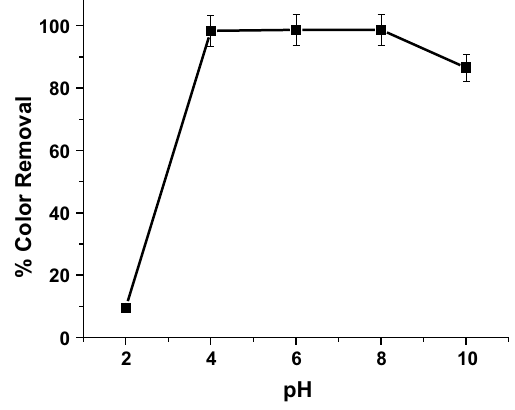
Fig. 3 Effect of pH on removal of EB (dye concentration: 100 mg/L, biomass: 100 mg, 4